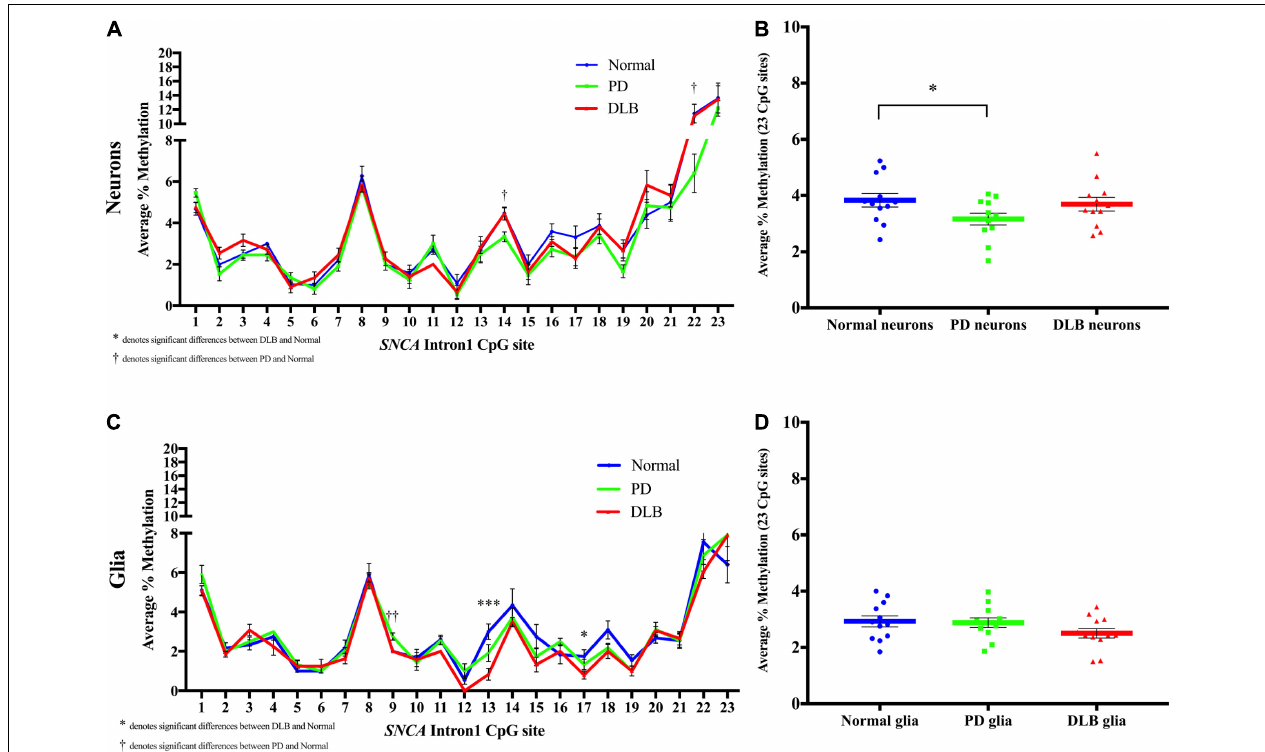
FIGURE 5 | DNA methylation profiles of the SNCA intron 1 CGI in the sorted neuronal and glia nuclei from frontal cortex tissues. DNA from each neuronal and glia sorted nuclei sample was bisulfite converted, and the methylation (%) of the individual CpGs was quantitatively determined by pyrosequencing. Graph depicts the average percentage of DNA methylation level at each of the 23 CpG sites within the SNCA intron 1 CGI for (A) neuronal nuclei and (C) glia nuclei from 20 PD, 20 DLB, and 20 matched normal control subjects. The significance of the differences in % of methylation was determined using one-way ANOVA followed by Dunnett’s post hoc test and denoted by asterisks ( ∗ ) for DLB vs normal, and by obelisks ( † ) for PD vs normal comparisons, with ∗ / † p < 0.05, ∗∗ / †† p < 0.005, and ∗∗∗ / ††† p < 0.001. Box-and-scatterplot charts display the DNA methylation average percentages across all 23 CpG sites within the SNCA intron 1 CGI [Chr4: 89,836,150-89,836,593 (GRCh38/hg38)] for each (B) neuronal and (D) glia nuclei isolated and sorted from each subject (denoted by colored points). The box plots also depict the mean (denoted by colored horizontal lines) and upper and lower quartiles (denoted by gray thin lines) of DNA methylation average percentages across all 23 CpG sites for all (B) neuronal and (D) glia sorted nuclei in each group of PD, DLB, and normal control. The significance of the differences in % of methylation was determined using Student’s t -test and repeated using one-way ANOVA followed by Dunnett’s post hoc test. ∗ indicates p < 0.05 for t -test; upon applying the Dunnett’s multiple comparisons method, the result did not reach statistical significance ( p =